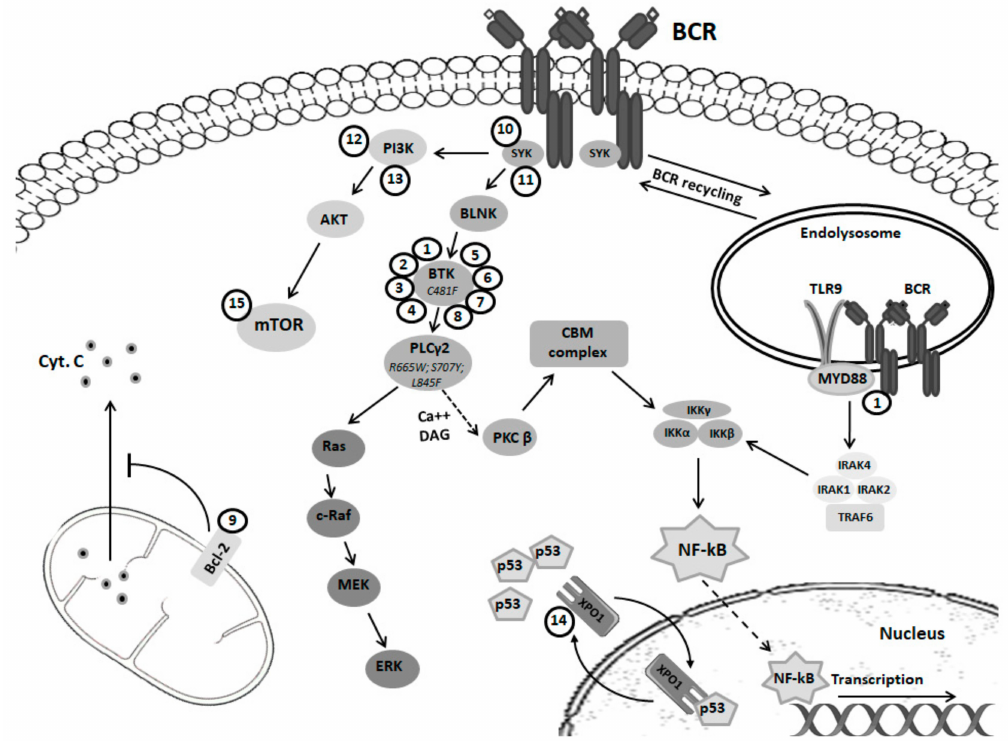
Figure 1. Overview of the B-cell receptor pathway. Shown are the B cell receptor (BCR) and signaling intermediates engaged in signal propagation following binding of the BCR to antigen. Numbers indicate inhibitors targeting particular components of the BCR signaling: (1) ibrutinib; (2) acalabrutinib; (3) zanabrutinib; (4) tirabrutinib; (5) GDC-0853; (6) vecabrutinib; (7) LOXO-305; (8) ARQ-531; (9) venetoclax; (10) entospletinib; (11) cerdulatinib; (12) duvelisib; (13) idelalisib; (14) selinexor; (15) CC-115. See main text for details. Bcl-2, B-cell lymphoma 2 protein; BLNK, B-cell linker protein; BTK, Bruton tyrosine kinase; CBM, CARD11–BCL-10–MALT1; Cyt.C, cytochrome C; DAG, diacylglycerol; ERK,